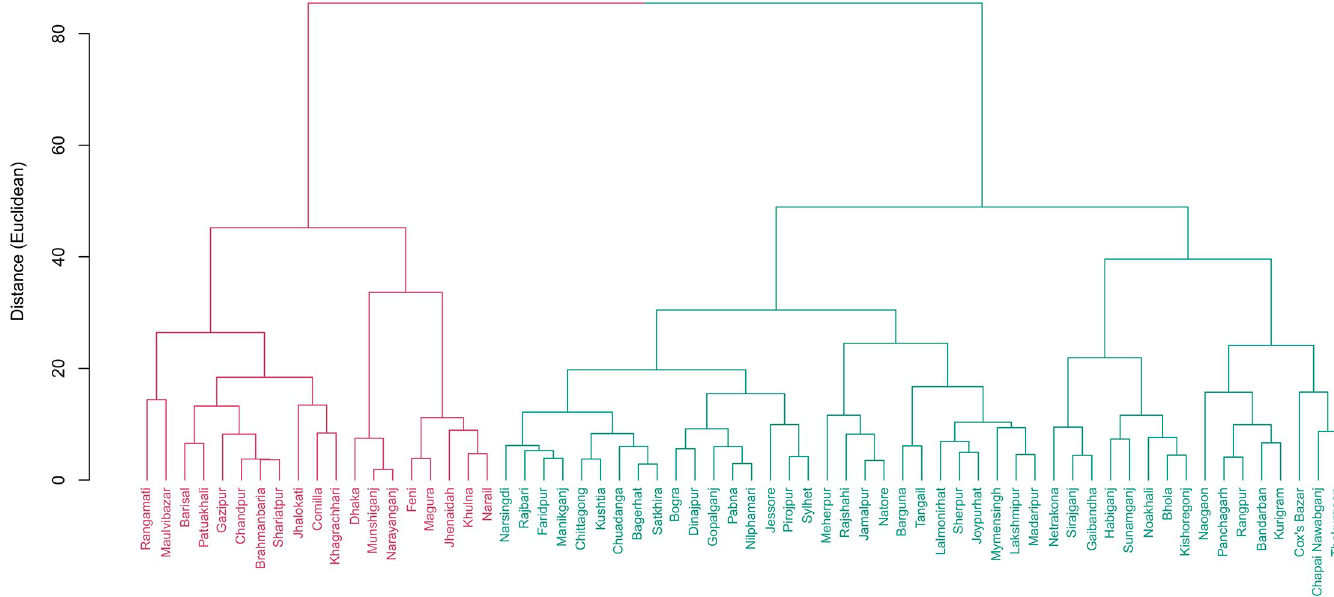
Fig 4. Cluster of districts based on nutrition indicators. Two clusters were found. Cluster 1 include 45 districts while 19 districts were in cluster